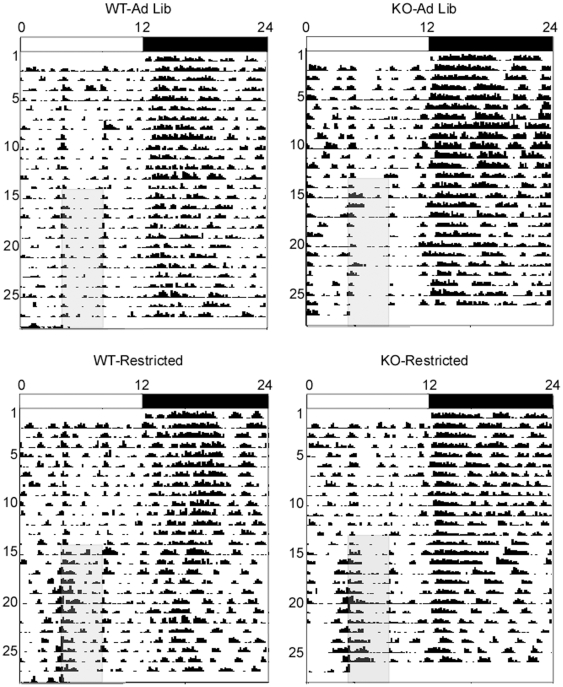
Representative actograms of WT and KO mice under ad libitum feeding conditions or a restricted feeding schedule.For all actograms in this study, each horizontal line represents a single 24-hour day, with the next day plotted on the next line. Vertical deflection reflect locomotor activity. The light/dark cycle is indicated by white/black bars above, the restricted feeding schedule and corresponding time window for ad libitum-fed control groups are indicated by gray shading.